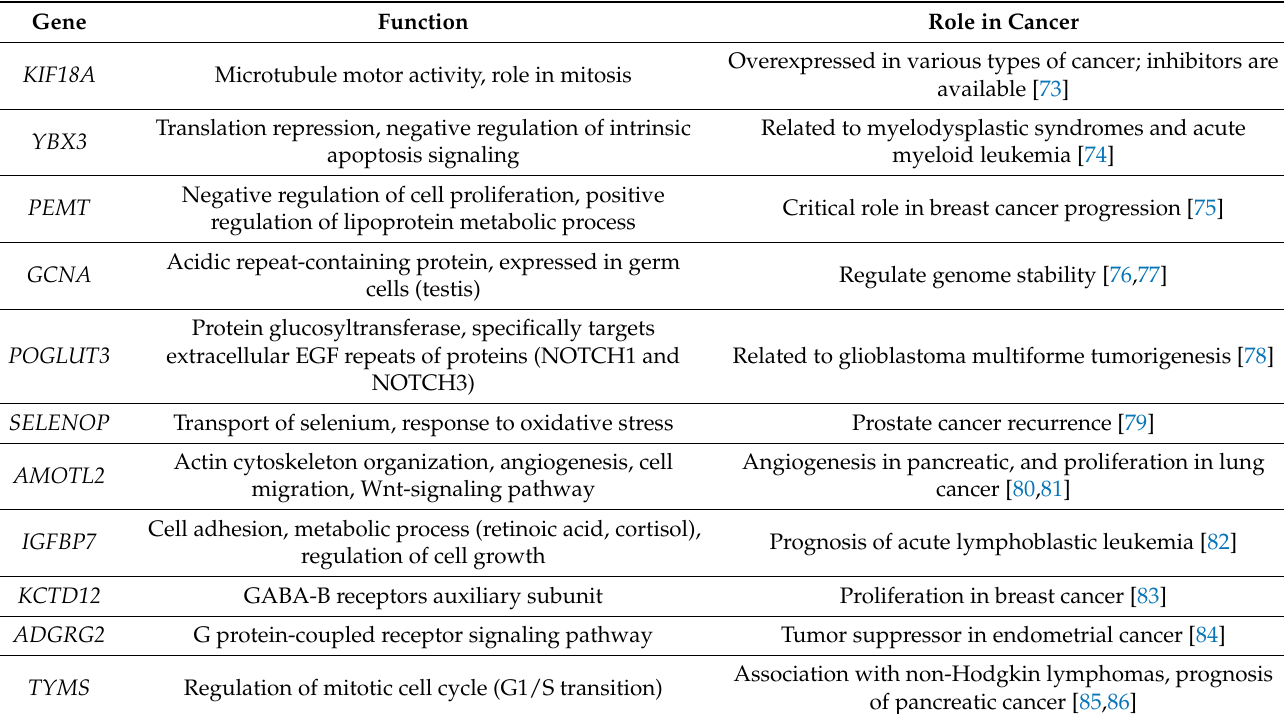
Table 5. Function and association of the highlighted genes in